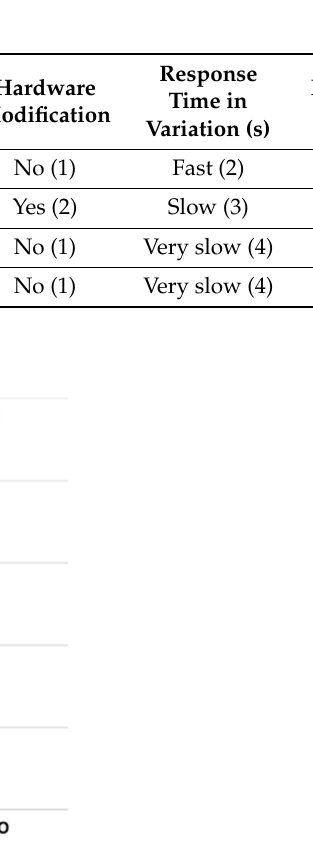
Figure 13. Graphical representation of MPPT rating.